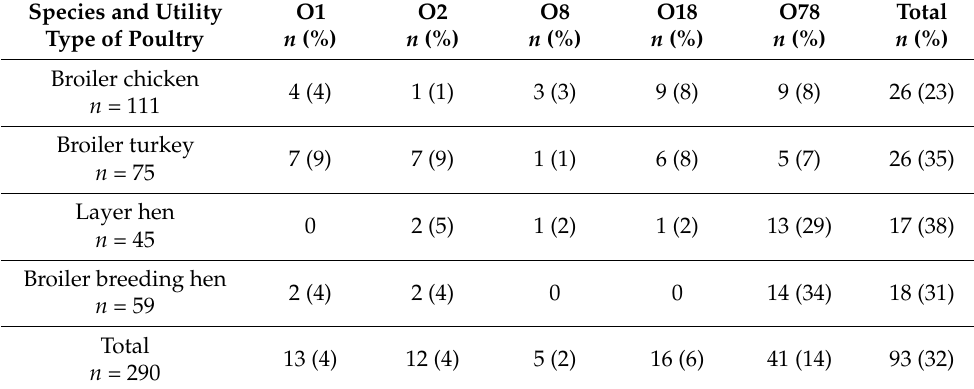
Table 3. Results of serological tests of E. coli strains showing positive reactions with diagnostic sera.